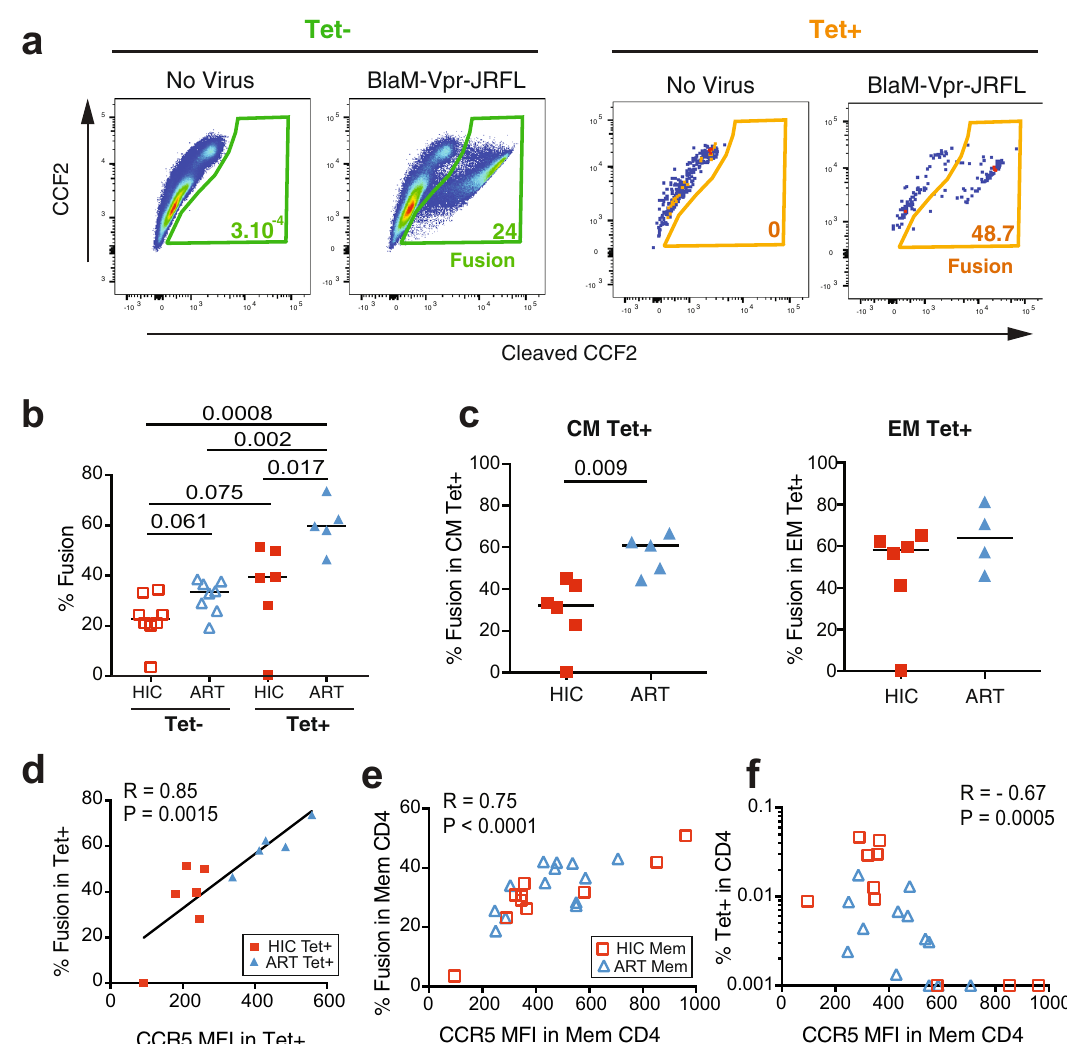
Fig. 5 Low susceptibility of controller Gag293-speci fi c CD4 + T cells to R5 HIV entry. HIV-1 JR-FL fusion was analyzed in Gag293-speci fi c (Tet + ) and non-speci fi c (Tet − ) memory CD4 + T cells from controllers (HIC) and treated patients (ART). a Example showing increased HIV fusion in Tet + compared with Tet − cells from one controller. b Comparison of HIV fusion in Tet + and Tet − cells from the HIC and ART groups. c Comparison of HIV fusion in central memory (CM, left) and effector memory (EM, right) Tet + populations between the HIC and ART groups. b , c Differences between medians were computed with the Mann-Whitney test. d Positive correlation between CCR5 expression and fusion in the Tet + population. e Positive correlation between CCR5 expression and fusion in the Mem (CD45RA − CD4 + ) population. f Inverse correlation between Tet + cells in CD4 + T cells and CCR5 expression in Mem cells. d – f Spearman correlation coef fi cients and associated P values are reported in plots. HIC Tet + Filled red squares, ART Tet + Filled blue triangles, HIC Mem Open red squares, ART Mem Open blue